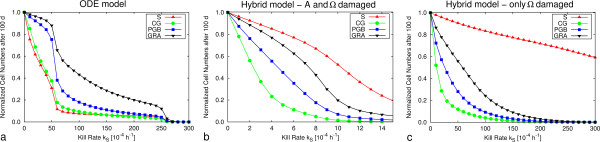
Simulations of chronic irradiation. Constant kill rates are applied to S, CG and PGB (with kCG = kPGB = 0.66 kS). Cell numbers in S, CG, PGB and GRA are recorded after 100 days. a) In the ODE model reductions in S and CG are similar. PGB and GRA almost maintain cell numbers at low doses. At higher doses cell numbers in PGB and GRA decrease rapidly. b,c) In the hybrid model damage in S is smaller than in all other compartments. b) If both GEs Α and Ω are damaged, the system is sensitive to kill rates that are an order of magnitude smaller than for the ODE model. c) If damage is restricted to GE Ω, the SCC is more robust at kill rates comparable to those of the ODE model. All other compartments are more sensitive in comparison to stem cells.